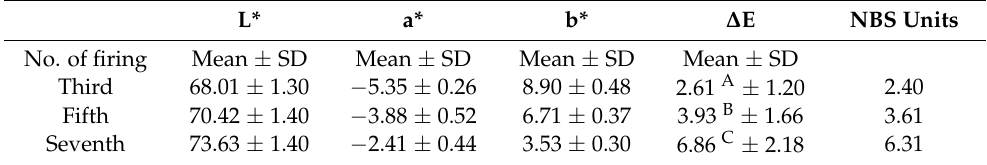
Table 2. Means and standard deviations for ΔE, ΔL, Δa, and Δb after the third, fifth, and seventh firing.